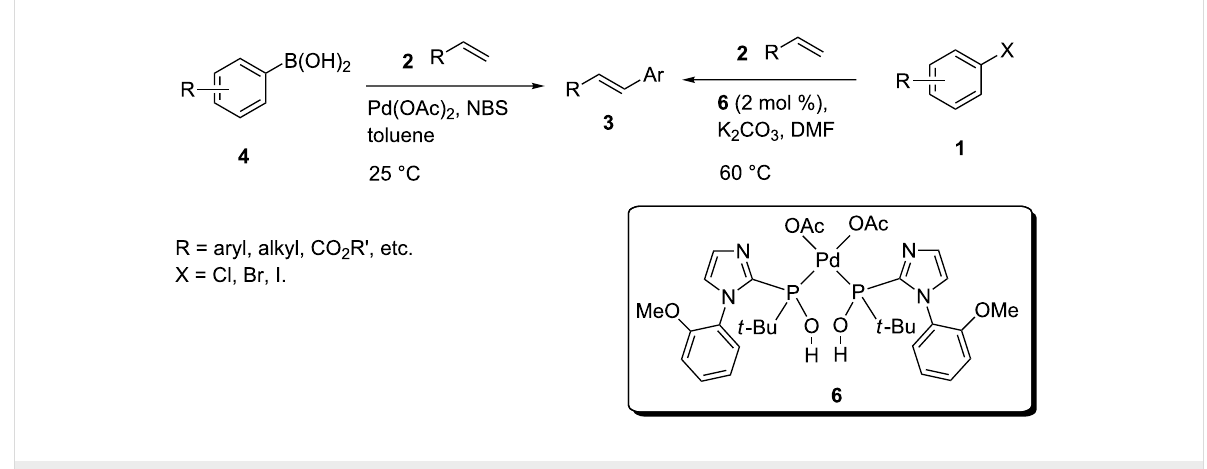
Scheme 1: Heck reaction of olefins with aryl halides and arylboronic acids.